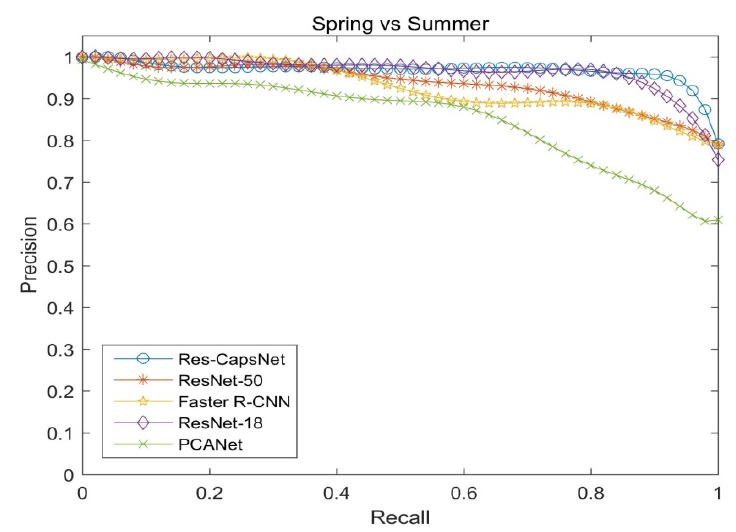
Figure 13. Precision–recall curves of four seasons comparison (spring vs. summer).